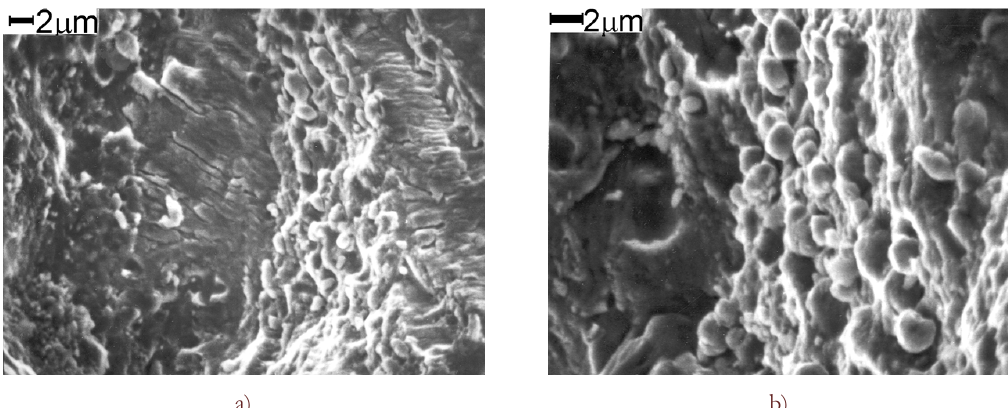
Figure 4: Spherical particles in area of cracked crosspieces of cruciform specimens of D16T aluminium alloy having formation during through crack propagation after single overloads with ( а ) 130 MPa,